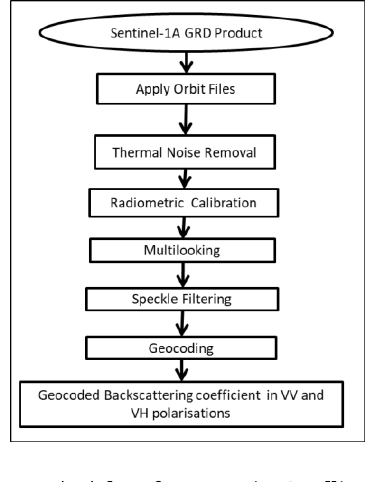
Figure 1. Methodology for processing Satellite